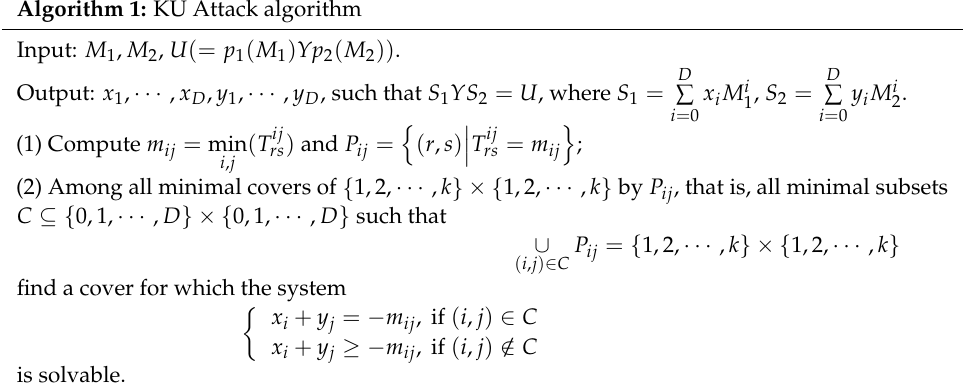
Algorithm 1: KU Attack algorithm